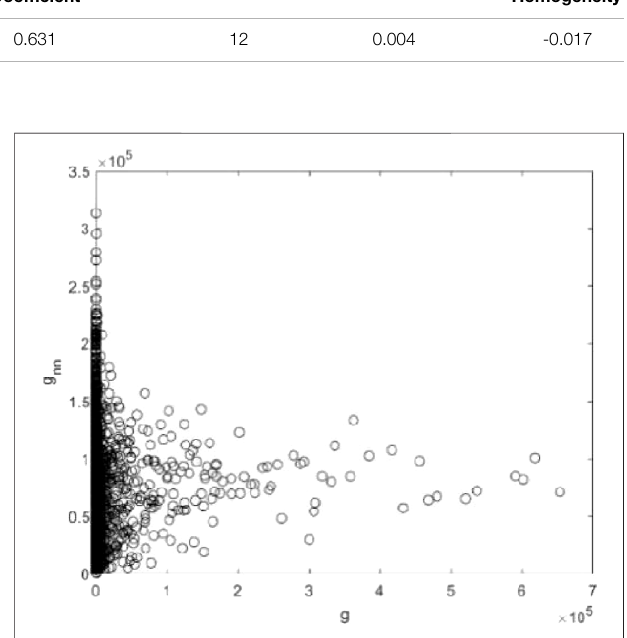
FIGURE 4 | Degree distribution of the air transportation network.